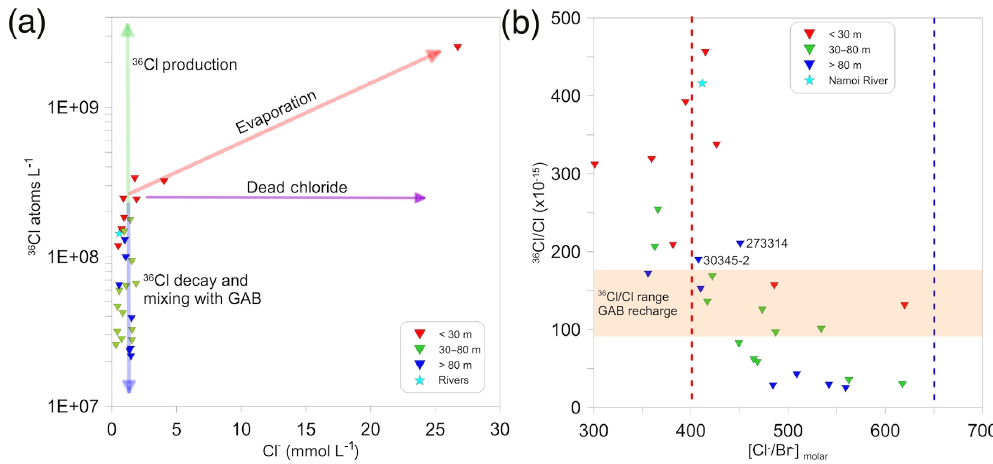
Figure 8. (a) 36 Cl vs. Cl − concentration. The 36 Cl production arrow represents potential in situ 36 Cl production from the high U and Th content in the host rocks. (b) 36 Cl / Cl ratio ( × 10 − 15 ) vs. Cl − / Br − . The dotted blue line represents the Cl − / Br − ratio in seawater and the dotted red line represents the expected Cl − / Br − ratio for rainfall at Narrabri based on distance from the coast (Short et al.,